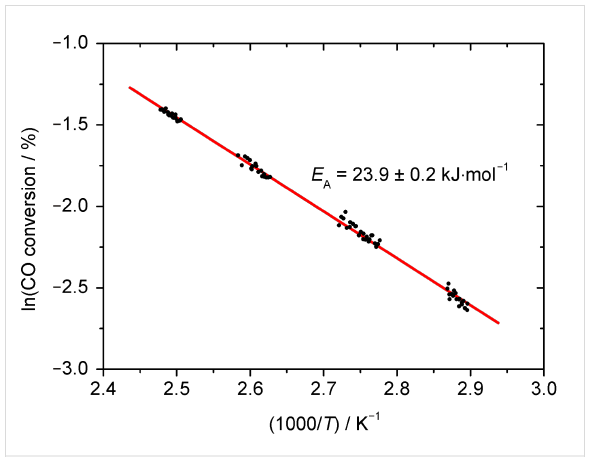
Figure 9: Arrhenius plot of the CO conversion, which is proportional to the CO oxidation rate, to determine the apparent activation energy E A for Au nanoparticles in a mesoporous TiO 2